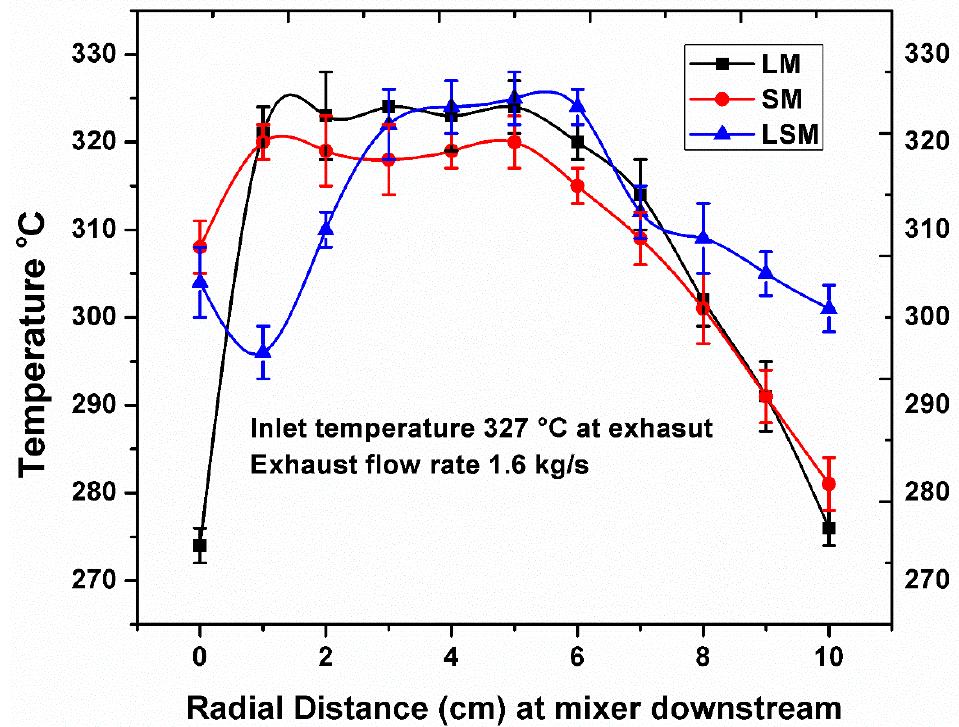
Figure 12. Radial distribution of temperature in the mixer downstream.